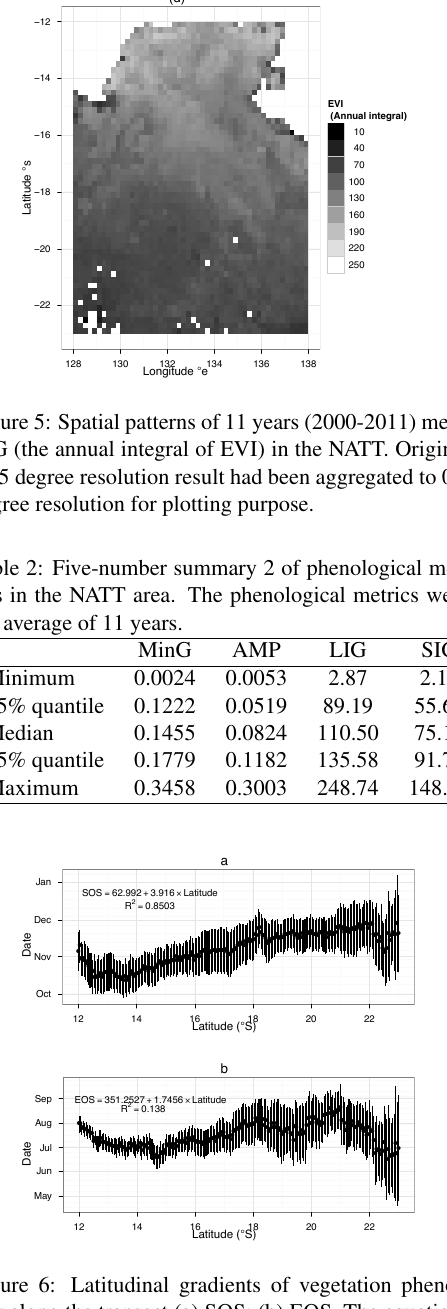
Figure 6: Latitudinal gradients of vegetation phenol- ogy along the transect (a) SOS; (b) EOS. The equations show the phenological metrics as a function of latitude. The vertical lines are the temporal standard deviations of these latitudinal